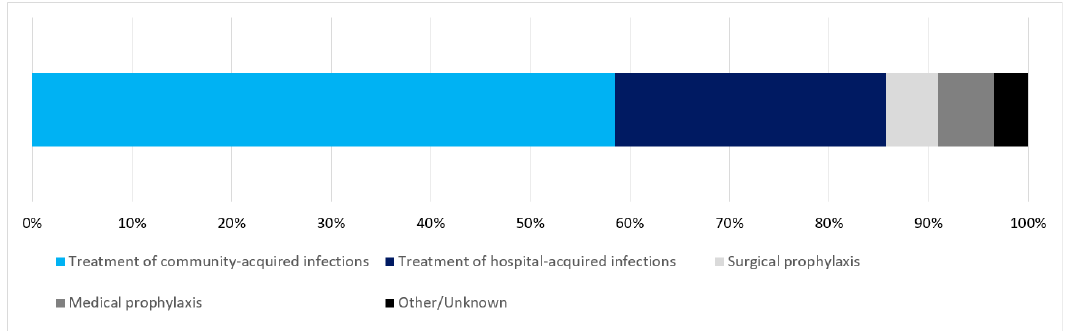
Figure 2. Indications of redundant anaerobic antimicrobial prescriptions as a percentage of all redundant anaerobic antimicrobial prescriptions ( N = 441). Data from 218 hospitals that participated in the point prevalence survey 2016. All redundant anaerobic antimicrobial prescriptions ( N = 441); Treatment of community-acquired infections ( N = 258); Treatment of hospital-acquired infections ( N = 120); Surgical prophylaxis ( N = 23); Medical prophylaxis ( N = 25); Other / Unknown indication ( N = 15).